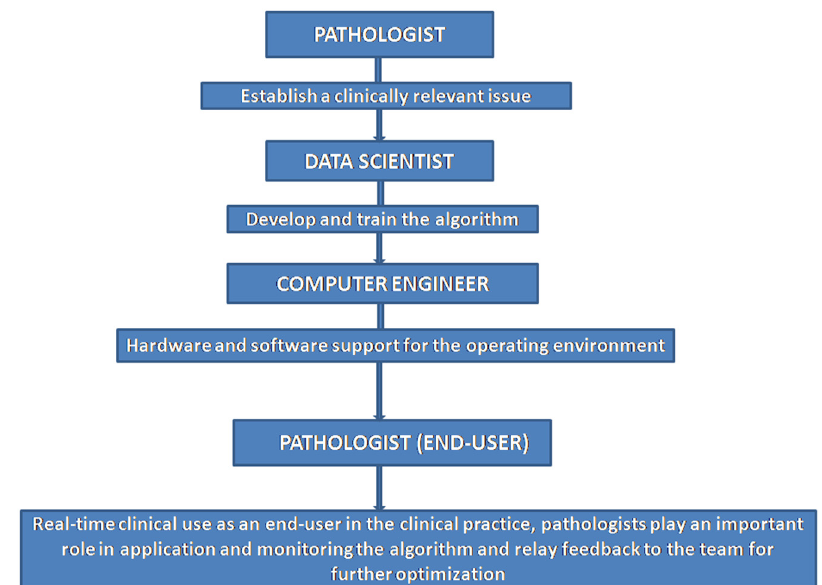
Figure 9. Computational pathology team (original diagram).